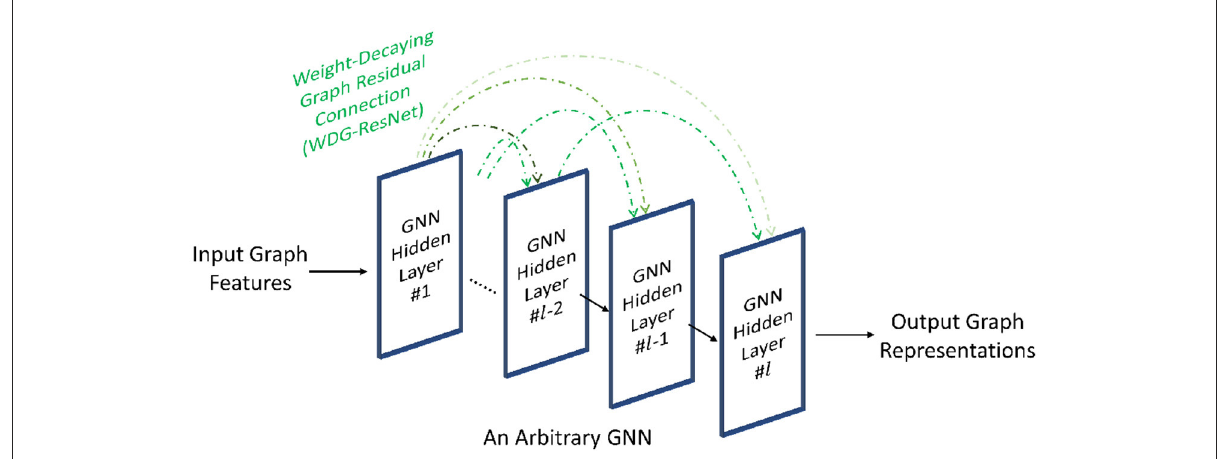
FIGURE4 Adding weight-decaying residual connections on an arbitrary GNN